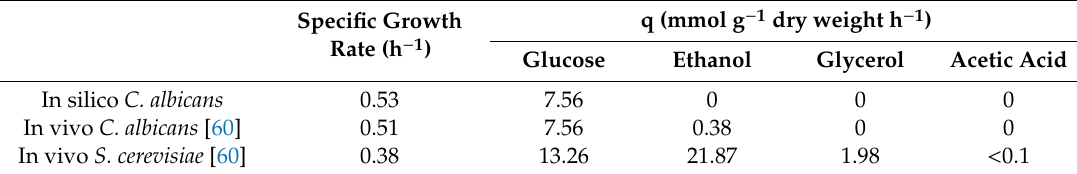
Table 4. Growth parameters of iRV781 and comparison with in vivo values for C. albicans and S. cerevisiae . Specific Growth